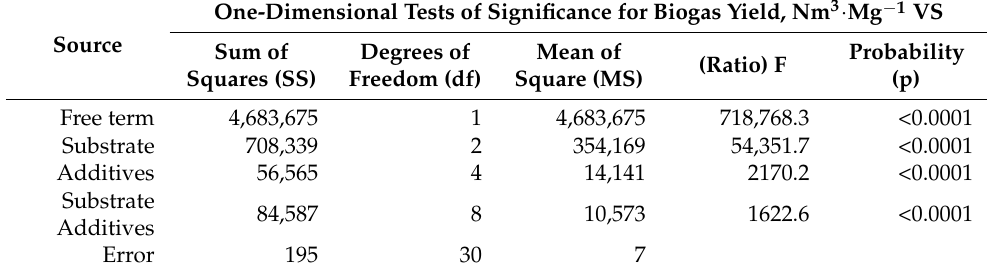
Table 2. Factorial variance in biogas and methane yields by substrate and enzyme type.